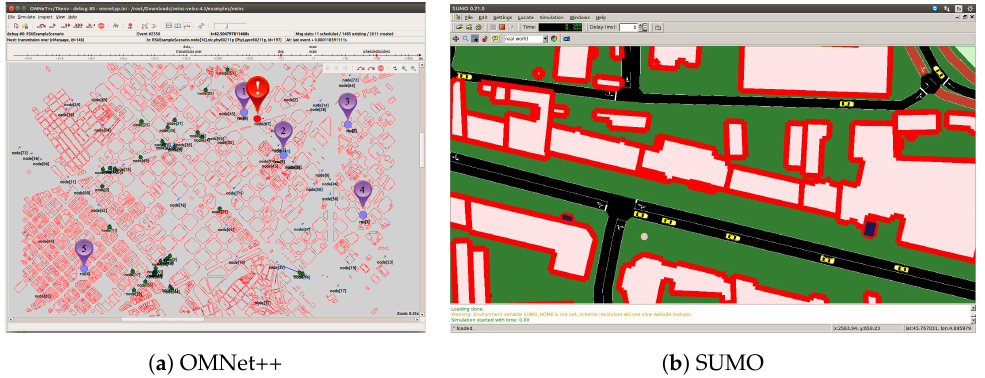
Figure 3. Screenshots of OMNet++ and SUMO simulators’ graphical user interfaces running network and road traffic simulations, respectively. Vehicular network scenario in OMNeT ++ : 2.5 km × 2.5 km urban region in Berlin, Germany (red rectangles = buildings; red circle = crashed vehicle; green circles = warned vehicles; purple circles =